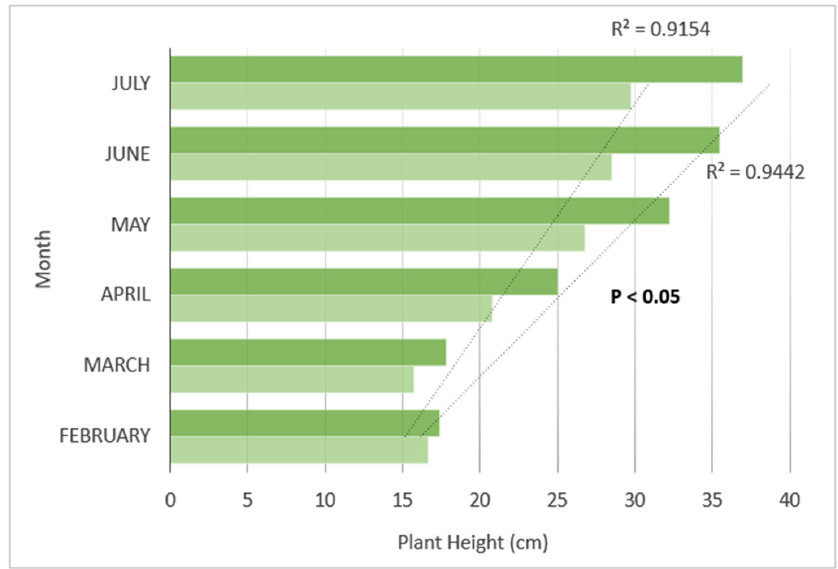
Figure 5. Artemisia californica plant height with unsterilized (dark green) compared to sterilized (light green) uninvaded soil inoculum.